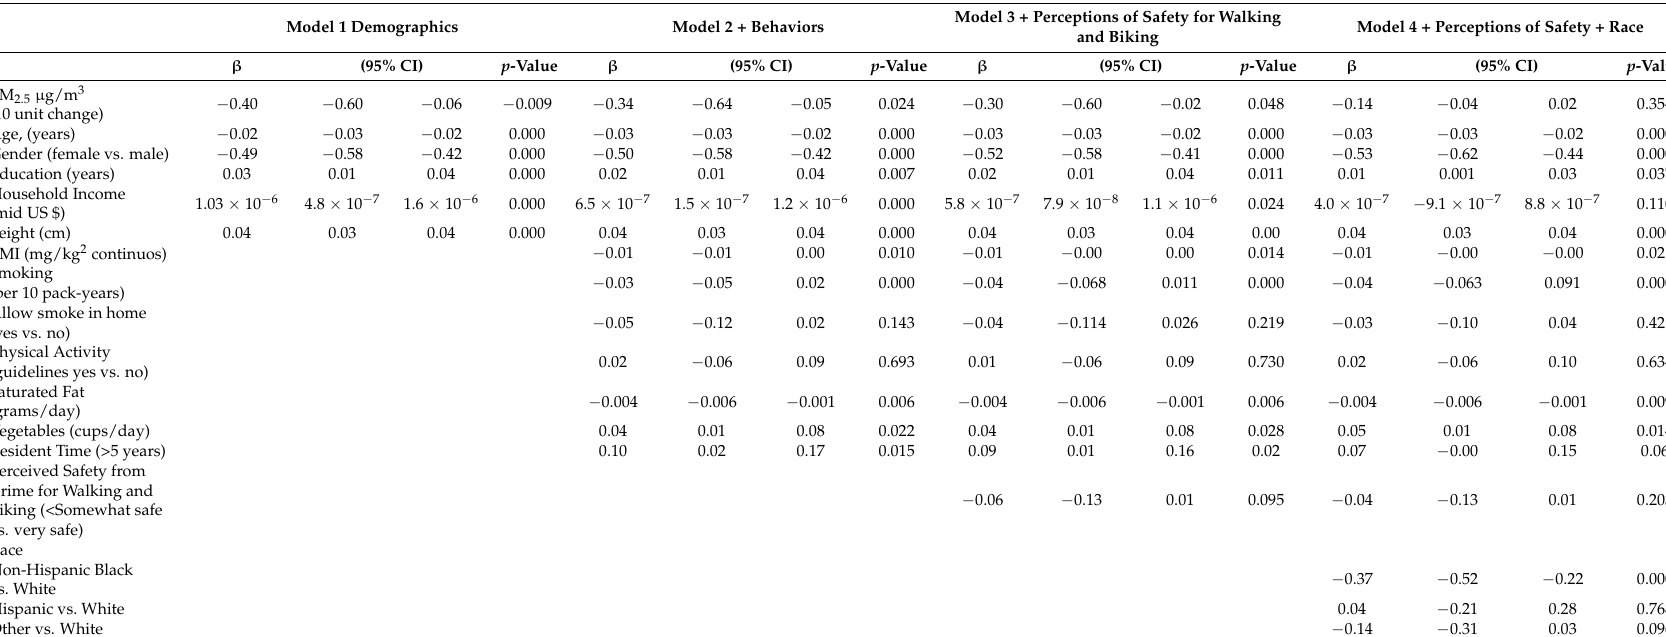
Table 4. Multiple Linear Regression estimating associations between lung function (FEV1-liters per 1 s) and ten unit change in 3-year Annual Average PM 2.5 ( µ g/m 3 )